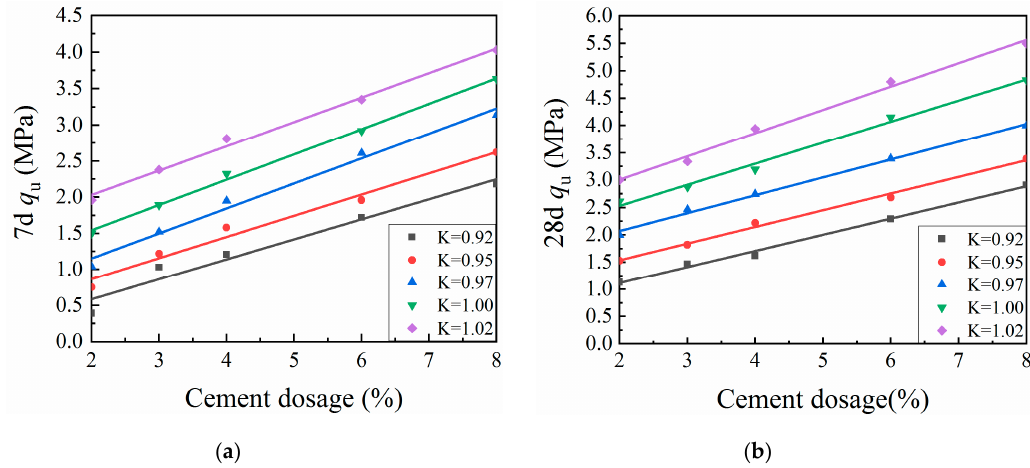
Figure 6. Relationship between cement dosage and unconfined compressive strength (UCS) of cement-modified loess (CML): ( a ) seven-day (7d) UCS; and ( b ) twenty-eight-day (28d) UCS.